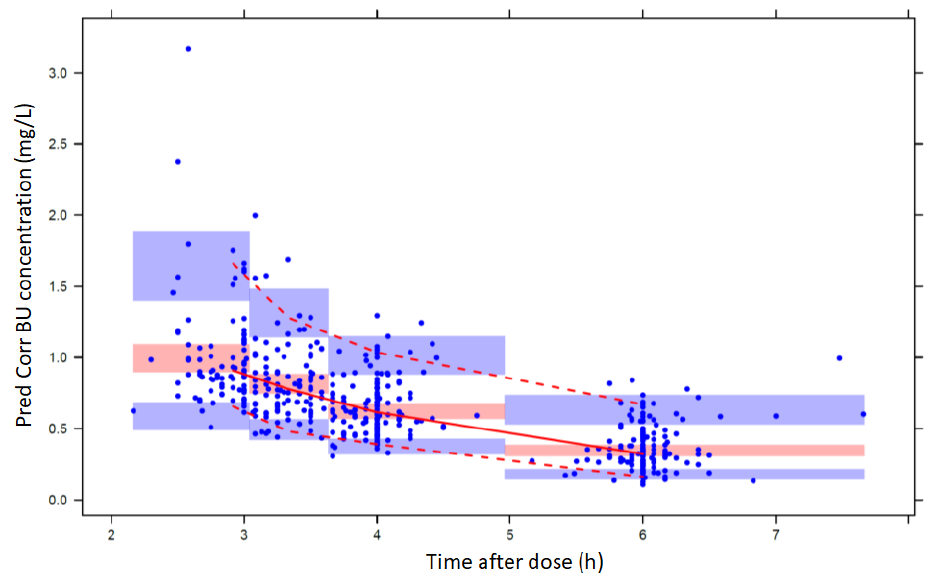
Figure 2. pcVPC for the final model. Red lines are the 5, 50 and 95% prediction intervals. The shaded areas represent the 95% confidence interval for the estimation.